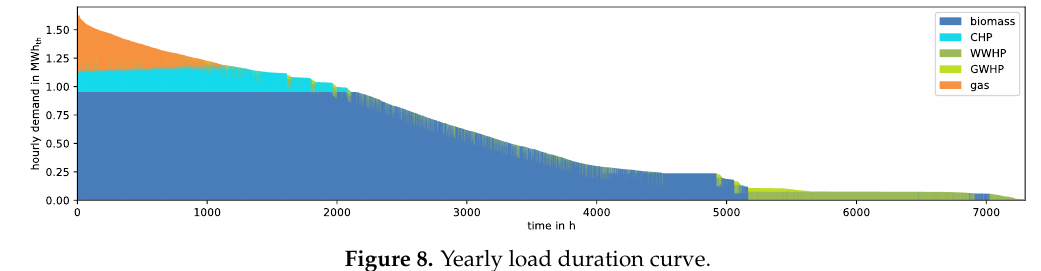
Figure 8. Yearly load duration